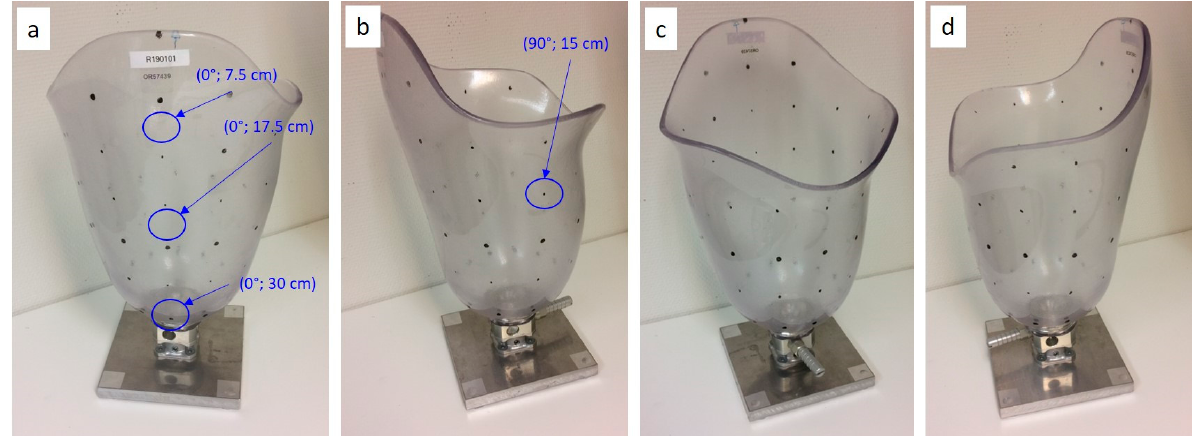
Figure 12. The test socket with coordinates applied to allow individual sensor sensels to be placed in identifiable locations, shown from the lateral ( a ), posterior ( b ), medial ( c ), and anterior view ( d ).